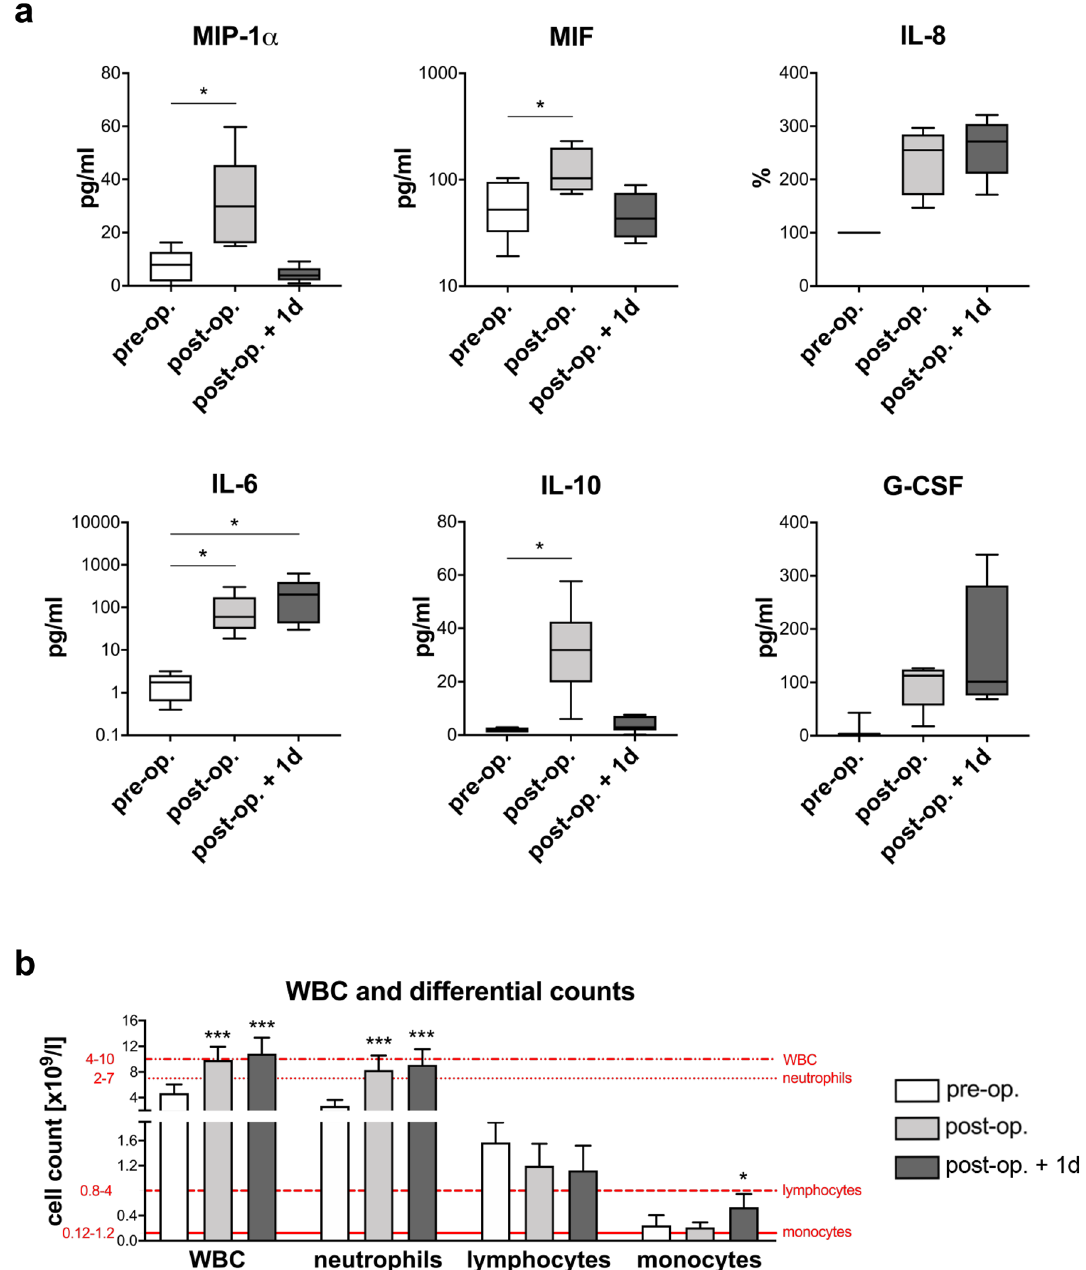
Figure 2. Blood after surgery shows changes in cytokine profiles and peripheral differential cell counts. Blood samples from six HLM patients taken before cardiac surgery (pre-operative), immediately after surgery (post- operative) and one day after admission to intensive care (post-operative + 1d) were analyzed for ( a ) cytokine levels (MIP-1α, MIF, IL-8, IL-6, IL-10, G-CSF) using Luminex technology and ( b ) white blood cell (WBC) as well as neutrophil, lymphocyte and monocyte counts using an automated hematology analyzer. Reference ranges of leukocytes are indicated in red. The plasma concentrations of cytokines are presented in pg/ml, except for IL-8. Levels for IL-8 in post-operative and post-operative + 1d blood samples were normalized to respective plasma levels within pre-operative blood (set to 100%) for each donor and means ± SD of the calculated percentages are shown. Significance was estimated using the unpaired, two-sided Student t test and shown as * P < 0.05, *** P <